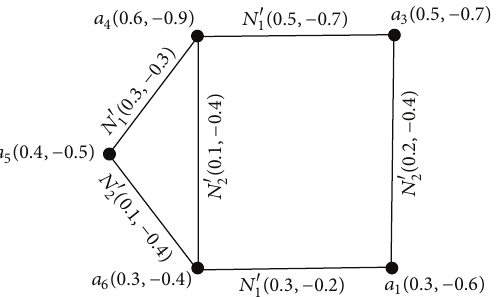
Figure 6: Bipolar fuzzy subgraph structure (𝑀 \ {𝑎 2 },𝑁 󸀠 1 , 𝑁 󸀠 2 ) .